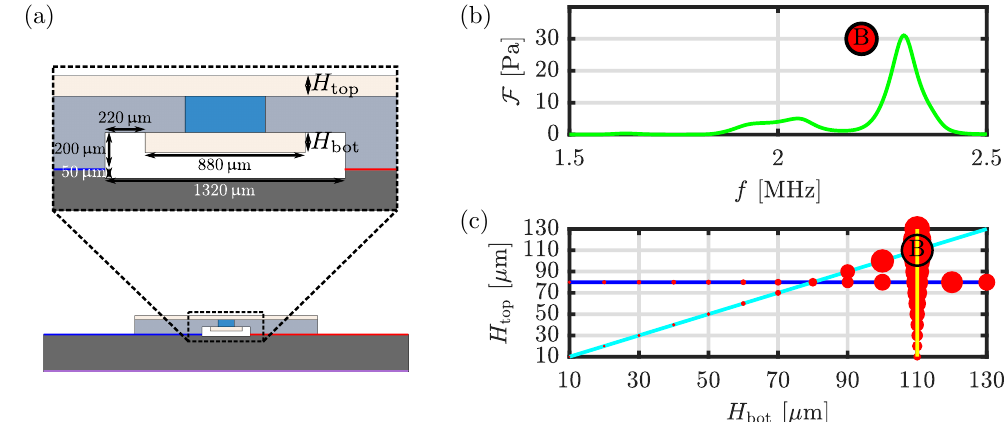
Figure 7. ( a ) Zoom-in on the channel in the dual-PDMS-cover setup, indicating the top cover thickness H top and the bottom cover thickness H bot . ( b ) Plot of the focusing figure of merit F versus frequency computed for the case H top = H bot = 110 µm leading to the identification of a strong resonance peak “B” at f = 2.302 MHz. ( c ) Scatter plot with area of the points proportional to the focusing figure of merit F for the strongest resonances identified in parametric sweeps of H = 80 µm (blue bot for fixed H top line), of H top for fixed H bot = 110 µm (yellow line), and for equal cover thicknesses H top = H bot (cyan line). The configuration with the highest focusing quality is indicated with an encircled